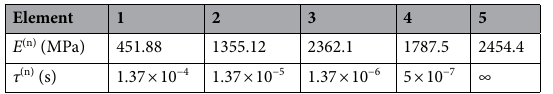
Table 2. Young’s modulus and relaxation parameter for PBX 9501.